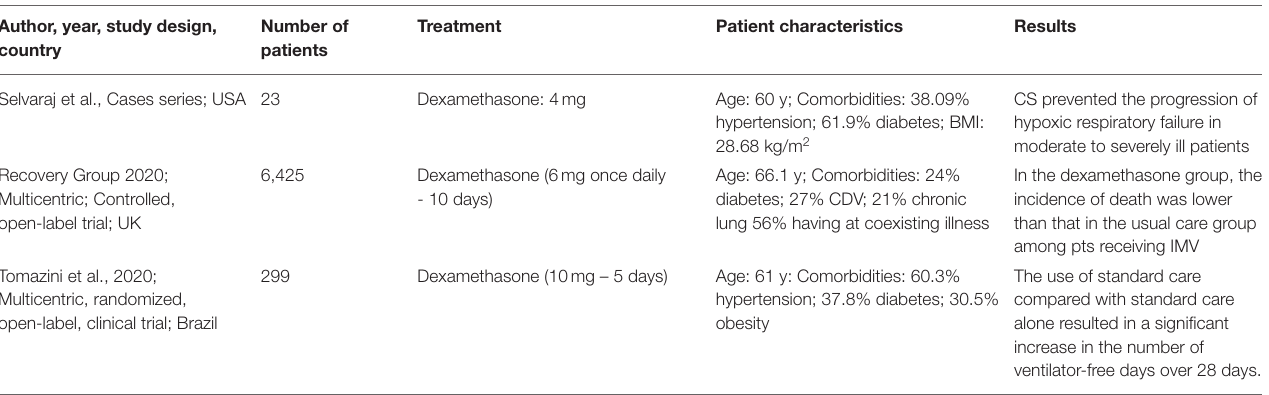
TABLE 2 | Studies on dexamethasone for